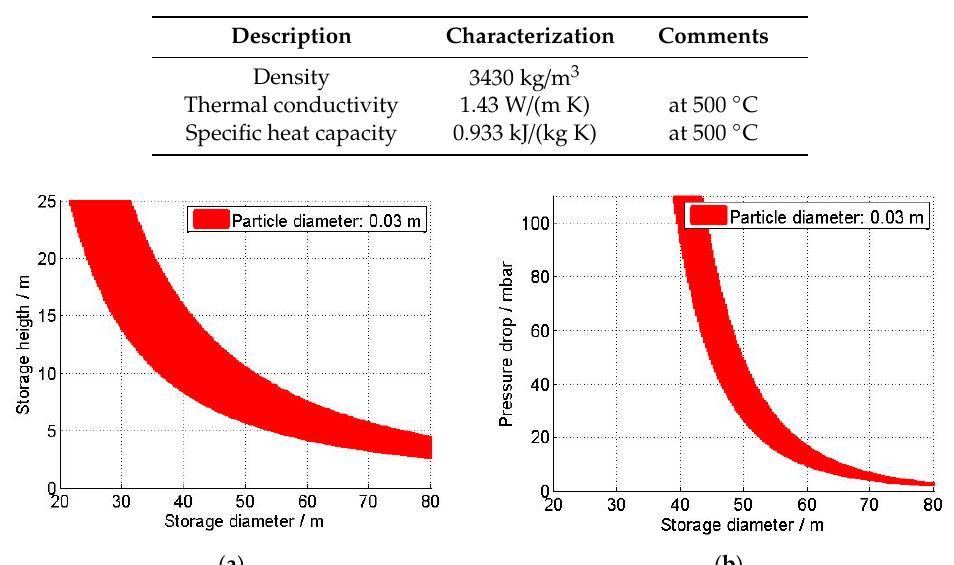
Table 2. Electric arc furnace (EAF) slag characteristics [7].